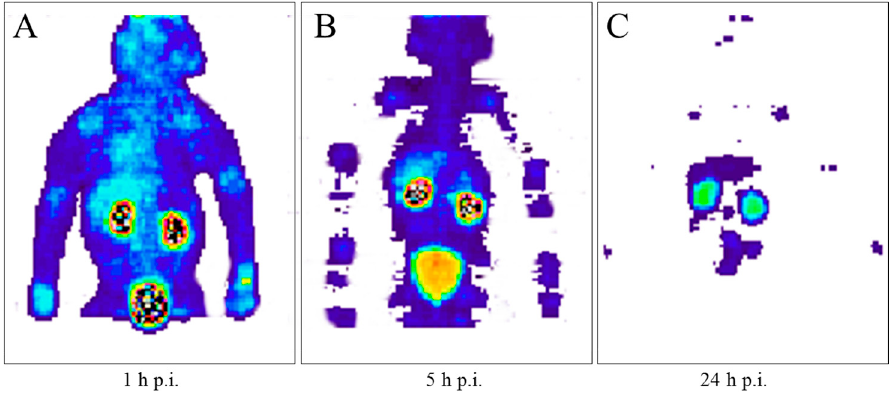
Figure 15. Whole-body PET scans of Baboons A–C injected with 10–40 MBq [ 86 Y]DOTA-DPhe 1 -Tyr 3 -octreotide per baboon containing 100 μ g/m 2 peptide recorded at 1 h p.i. ( A ), 5 h p.i. ( B ) and 24 h p.i. ( C ). In this case, there was no simultaneous amino acid co-infusion. The anterior view images are summations of all coronal slices.